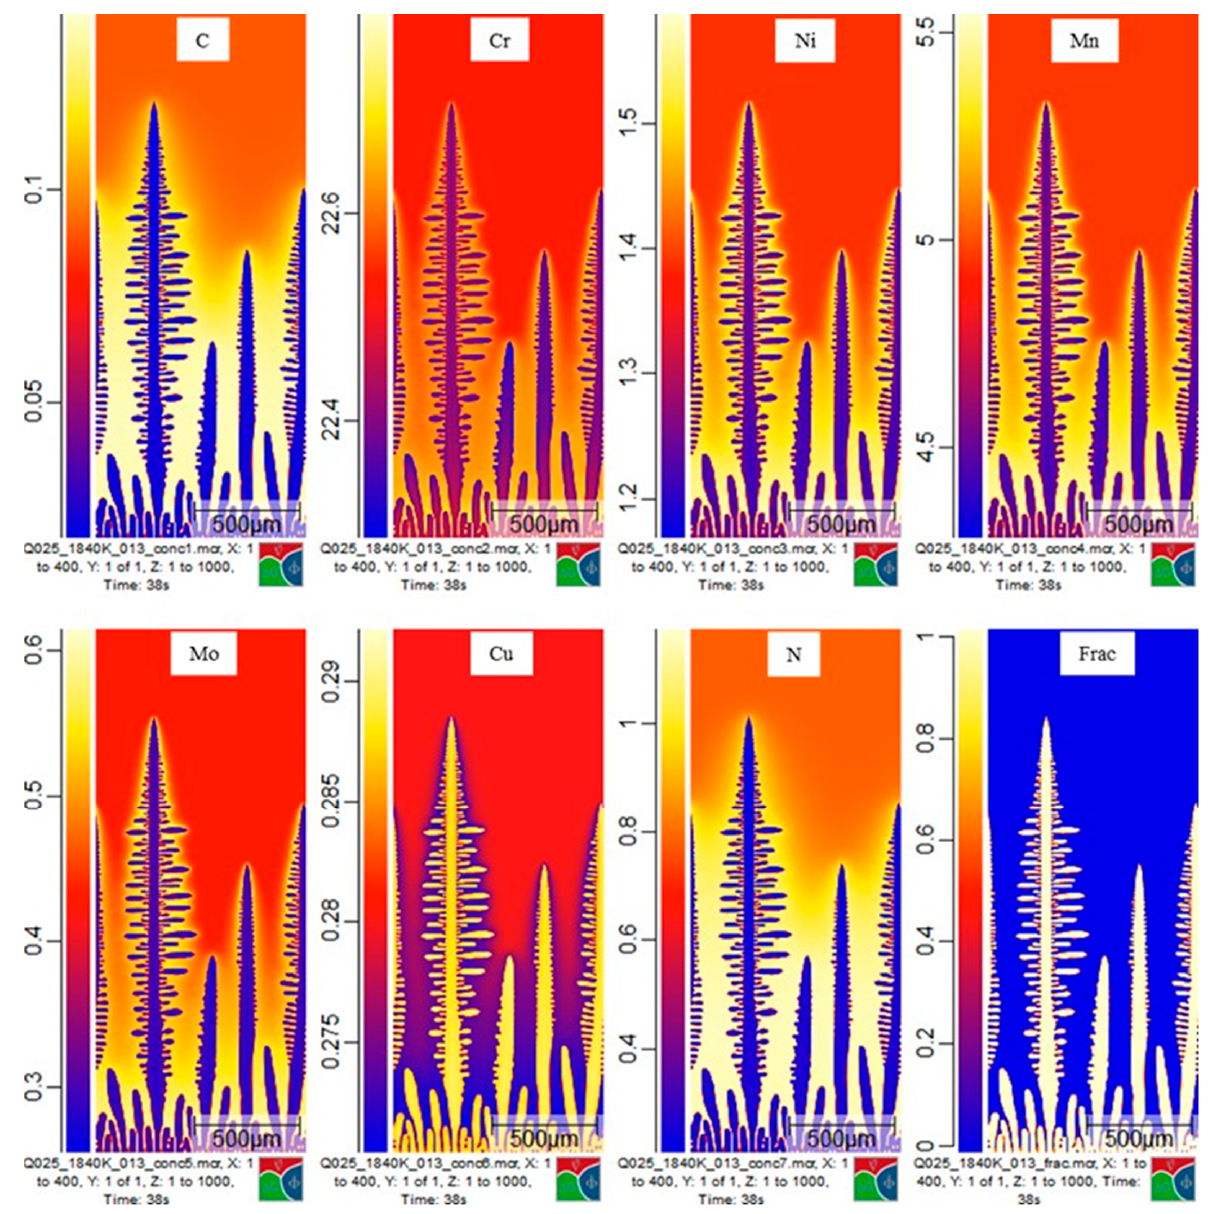
Figure 13. S32101, 100 °C superheated at 10 mm in the slab. Segregation of seven elements displayed from one timestep of a simulation run.